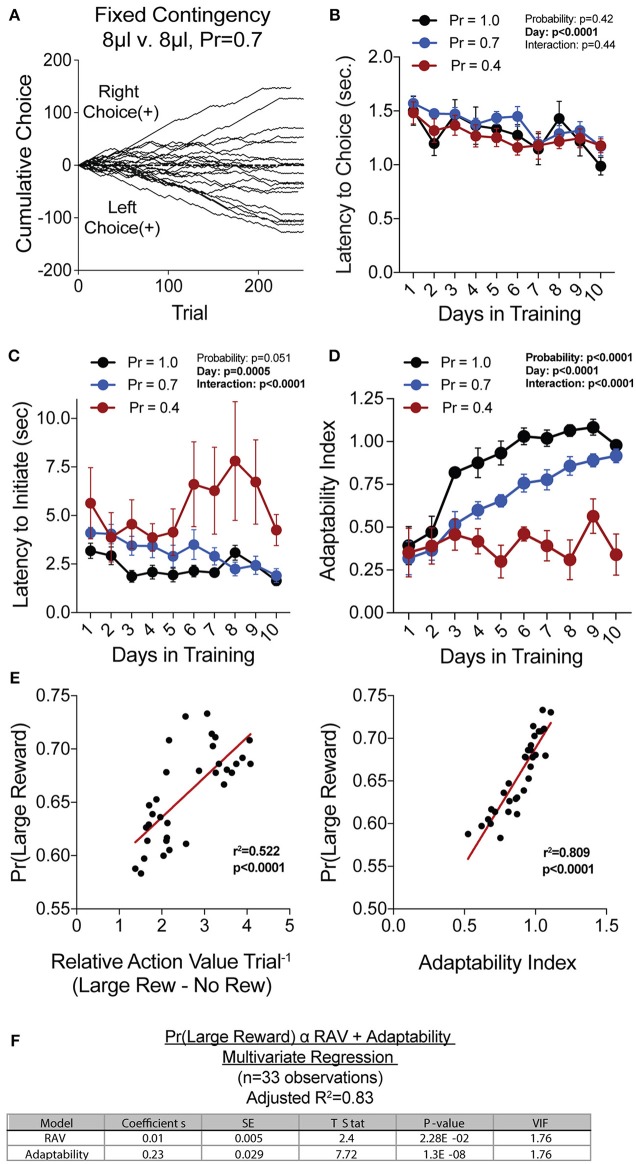
Acquisition of value-based choice paradigm is accompanied by dynamic changes in motor-efficiency and behavioral flexibility: (A) Choice patterns in the absence of benefit differences show that some mice continually sample the two available options while others develop significant choice bias. (B,C) As animal acquire the reversal task, they display increased motor efficiency in the execution of the task, including the speed with which choices are made [latency to choice (B)] and the speed with which trials are initiated [latency to initiate (C)]. (D) Adaptability, a measure of choice flexibility, shows a probability-dependent increase with training. (E) Both the relative action value (left) and the adaptability index (right) have significant linear relationships with overall task performance in an individual session (data from Days 8,9,10 of n = 11 mice at Prew = 0.7) (F) Bivariate linear regression analysis of session performance against RAV and the Adaptability Index indicates that both of these variables are significant, with minor multicollinearity (VIF = 1.76). Together, they account for 83% of variability in session performance of mice.